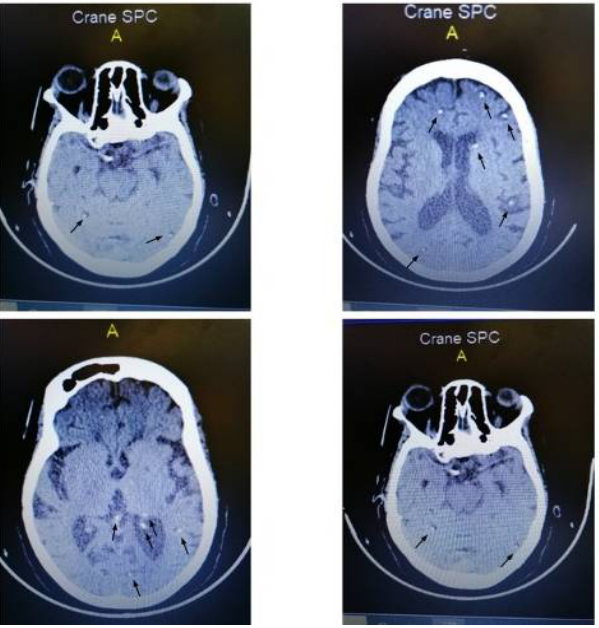
Figure 1. Brain CT scan showing multiple, randomly distributed, round cystic lesions with white dot sign of 4–8 mm in diameter.